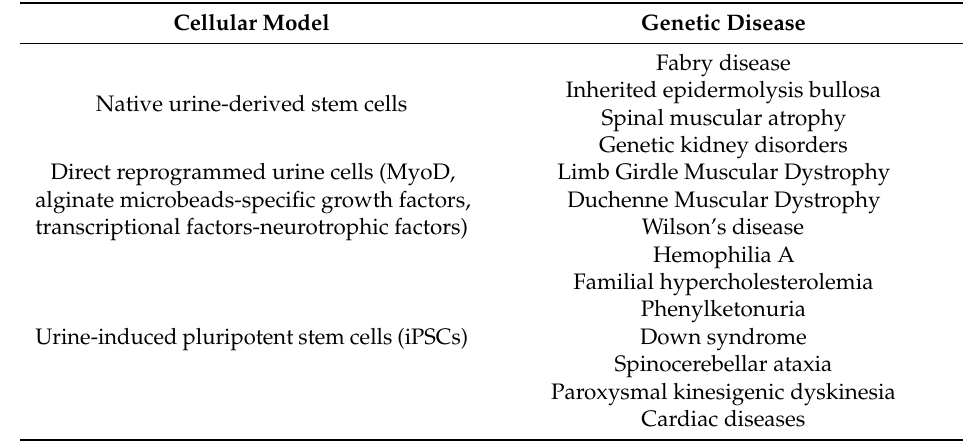
Table 1. Urine-derived cells can be used to generate di ff erentiated cells for modelling genetic